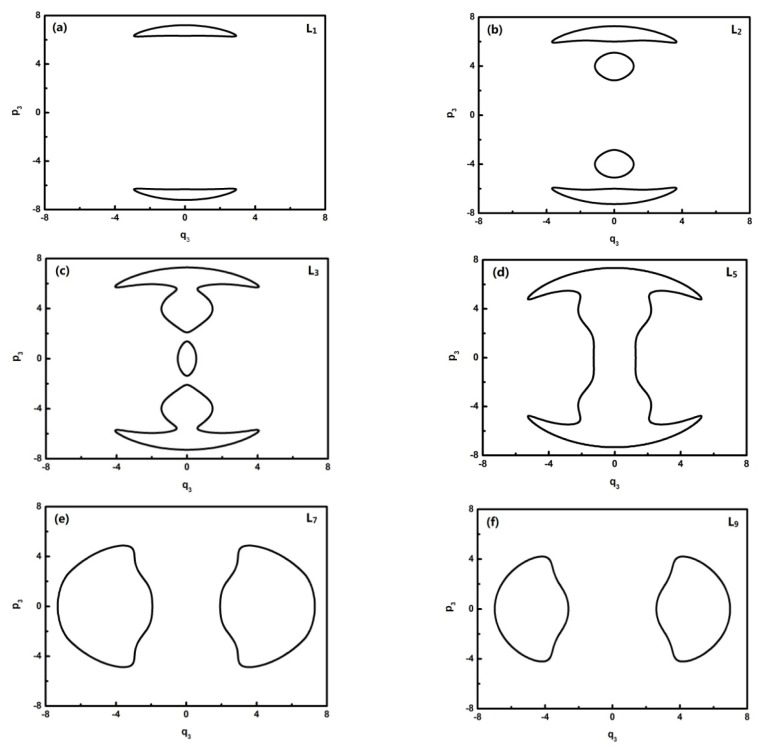
The trajectories of phase space of L1, L2, L3, L5, L7, L9 (q3 coordinates).